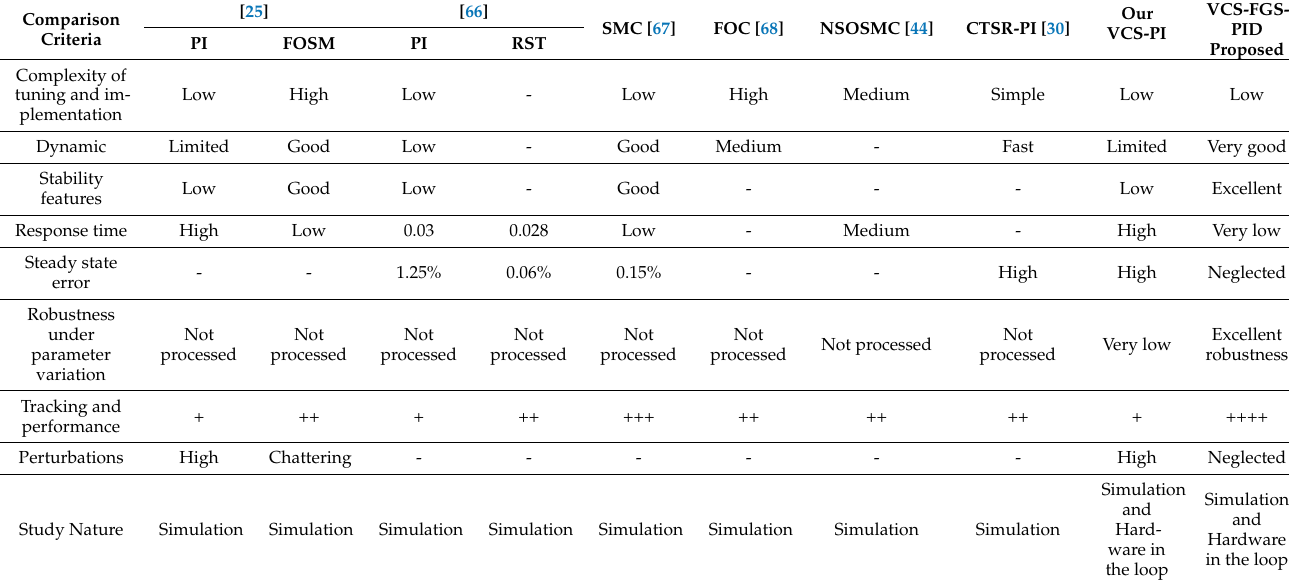
Table 8. Comparison between studied